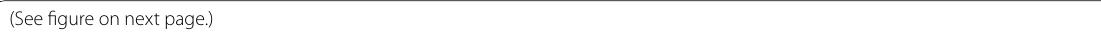
Fig. 6 The reduction of protein translation promotes Vegfa expression independent of Hif1α . a Western blot analysis of the p-Eif2α, Eif2α, and α-tubulin of B16-Red transplant microtumor at avascular (about 12 h)and first vessel stage (about 24 h) ( n the p-Eif2α, Eif2α, and α-tubulin of B16-Red tumor spheroids at 0, 12 and 24 h. c RT-qPCR quantification of Vegfa expression in B16-Red tumor spheroids at 0, 12 and 24 h. d Western blot analysis of the p-Eif2α, Eif2α, and α-tubulin of puromycin (2 μg/mL) treated B16-Red cells at 0, 1